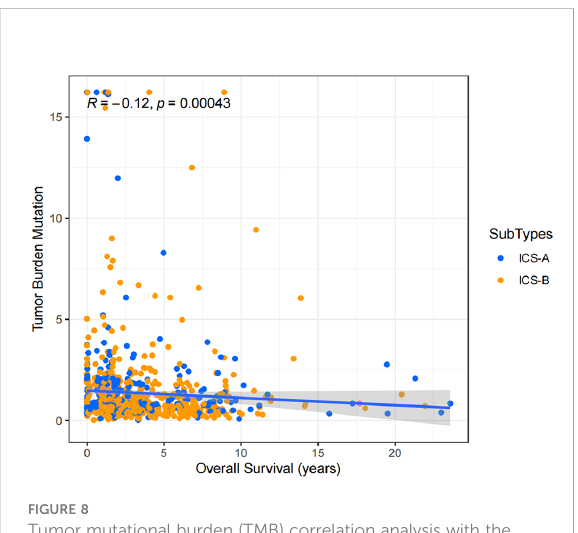
FIGURE 8 Tumor mutational burden (TMB) correlation analysis with the overall